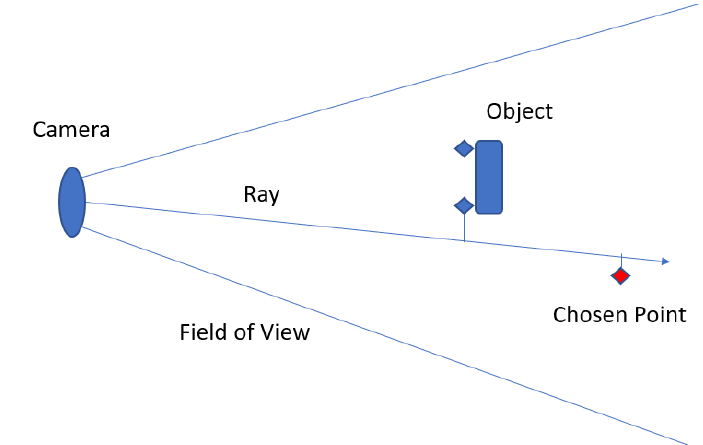
Figure 7. Visualization of how the algorithm can choose the wrong feature point, leading to large discrepancies in depth and subsequently scaling and positioning.